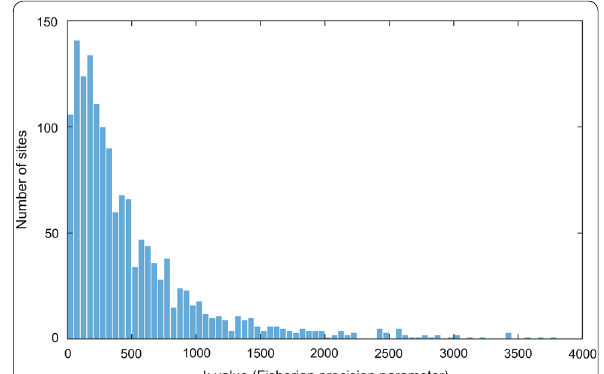
Fig. 11 Histogram of k values. Distribution of ICEPMAG sites by reported k value (limited to < 4000 )